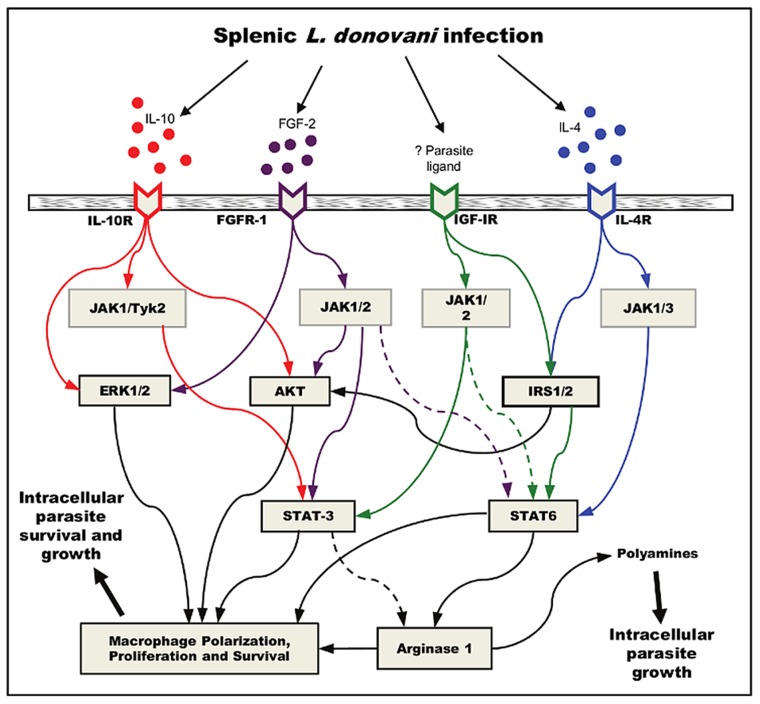
Working model for convergent signaling of growth factors and cytokines in the induction of arg1 in VL.
L. donovani infection induces the production of IL-4, IL-10 and FGF-2 in the spleen. FGFR is activated, as is IGF-IR by a yet to be identified host or parasite ligand. JAK kinases are phosphorylated through the activated cytokine or growth factor receptors, which lead to IRS-1/2, AKT, ERK, and STAT activation. Translocated STAT6, and possibly STAT3 lead to the transcriptional activation of arginase, which generates polyamines from arginine and leads to parasite growth. These transcription factors also contribute to the polarization macrophages toward an M2 phenotype, which is more permissive to L. donovani survival and growth. The collective effect of AKT, ERK, and STAT3 activation, and the generation of polyamines, are likely to lead to growth, proliferation and survival of arginase expressing cells, but this needs experimental confirmation in VL. Solid lines indicate known mechanistic interactions; dashed lines represent suppositional interactions. Only key shared signaling proteins are included in the model.